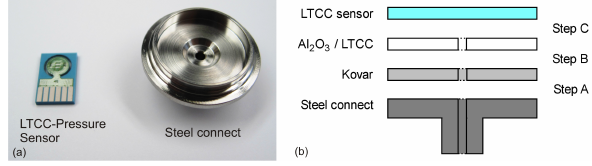
Figure 2. Single LTCC pressure and steel connect (a) and scheme for the stepwise integration of a LTCC-based sensor element into the steel connect (b)